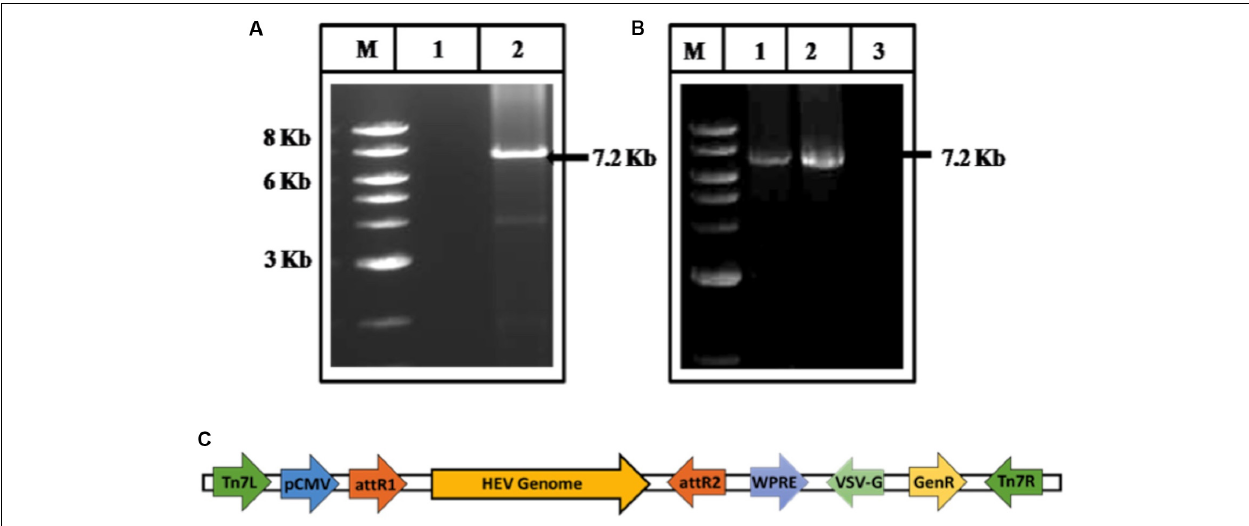
FIGURE 1 | Cloning of HEV genome (A) amplification of HEV genome from cDNA of pSHEV-3. The corresponding lanes are as follows: marker (lane M), No template control (lane 1), amplified pSHEV-3 product (Lane 2). (B) PCR amplification of HEV genome from BacMam-HEV construct. The corresponding lanes are as follows: Marker (lane M), Positive Control (amplified cDNA of pSHEV-3) (lane 1), an amplified product from BacMam-HEV construct (lane 2), No template control (lane 3). (C) Schematic representation of the BacMam-pCMV-Dest vector carrying the HEV